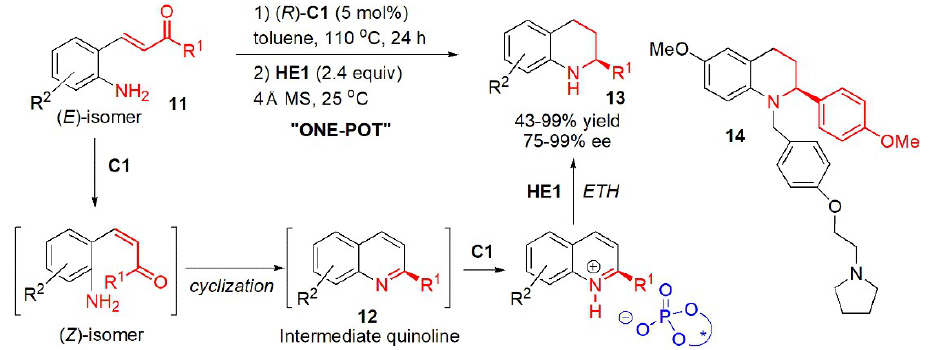
Figure 7. Enantioselective synthesis of THQs from 2-aminochalcones via a consecutive one-pot reaction catalyzed by ( R )- C1 [50].